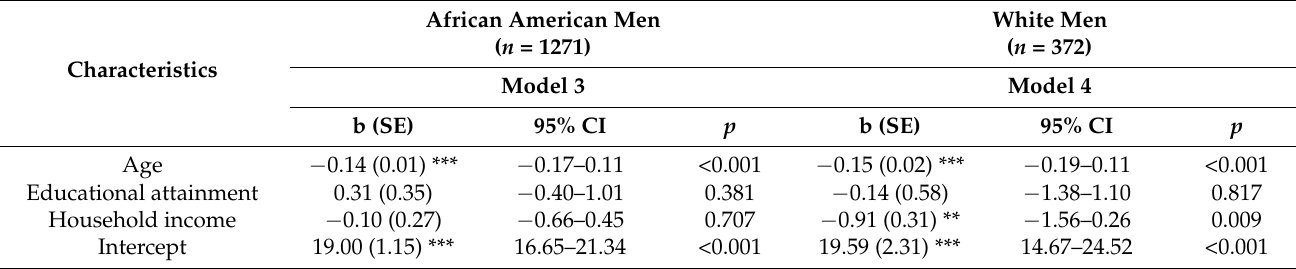
Table A1. Summary of linear regressions on the effects of educational attainment and household income as interval variables on perceived discrimination in African American and Non-Hispanic White men in the National Survey of American Life (sensitivity analysis).